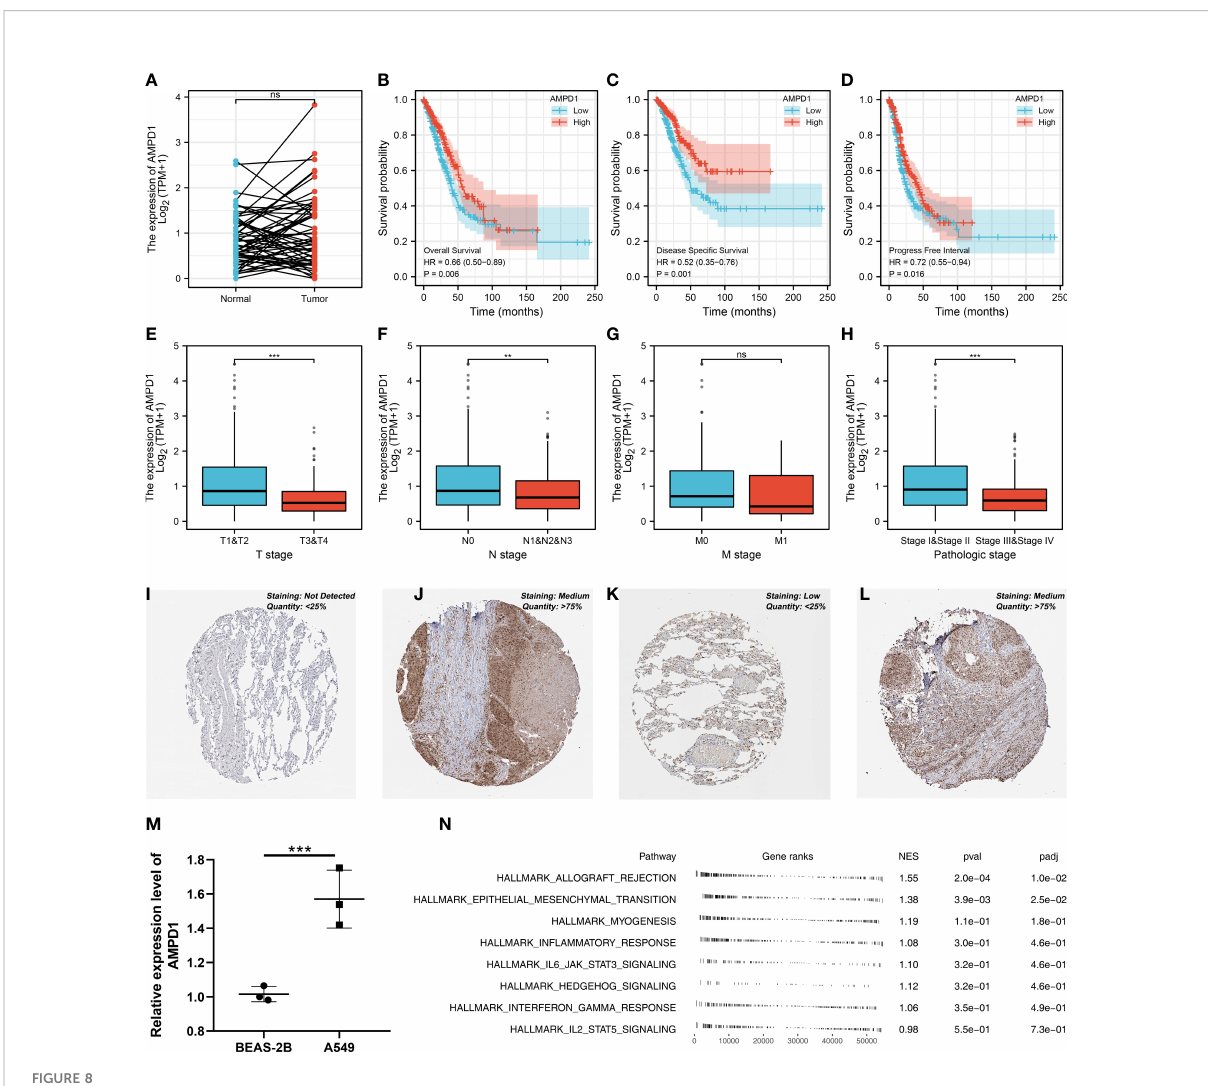
FIGURE 8 Further exploration of AMPD1 in lung cancer. (A) The expression level of AMPD1 in paired LUAD and control tissue, ns P > 0.05; (B) The OS in patients with low and high AMPD1 expression level; (C) The DSS in patients with low and high AMPD1 expression level; (D) The PFI in patients with low and high AMPD1 expression level; (E) The correlation analysis between expression level of AMPD1 and T stage, ***P <0.001; (F) The correlation analysis between expression level of AMPD1 and N stage, **P < 0.01; (G) The correlation analysis between expression level of AMPD1 and M stage, ns P > 0.05; (H) The correlation analysis between expression level of AMPD1 and stage, ***P < 0.001; (I) The AMPD1 protein level in normal lung tissue; (J) The AMPD1 protein level in LUAD tissue; (K) The AMPD1 protein level in normal lung tissue; (L) The AMPD1 protein level in LUAD tissue; (M) The qRT-PCR assay demonstrated the expression level of AMPD1 in A549 and BEAS-2B cells, ***P < 0.001; (N) The GSEA analysis of